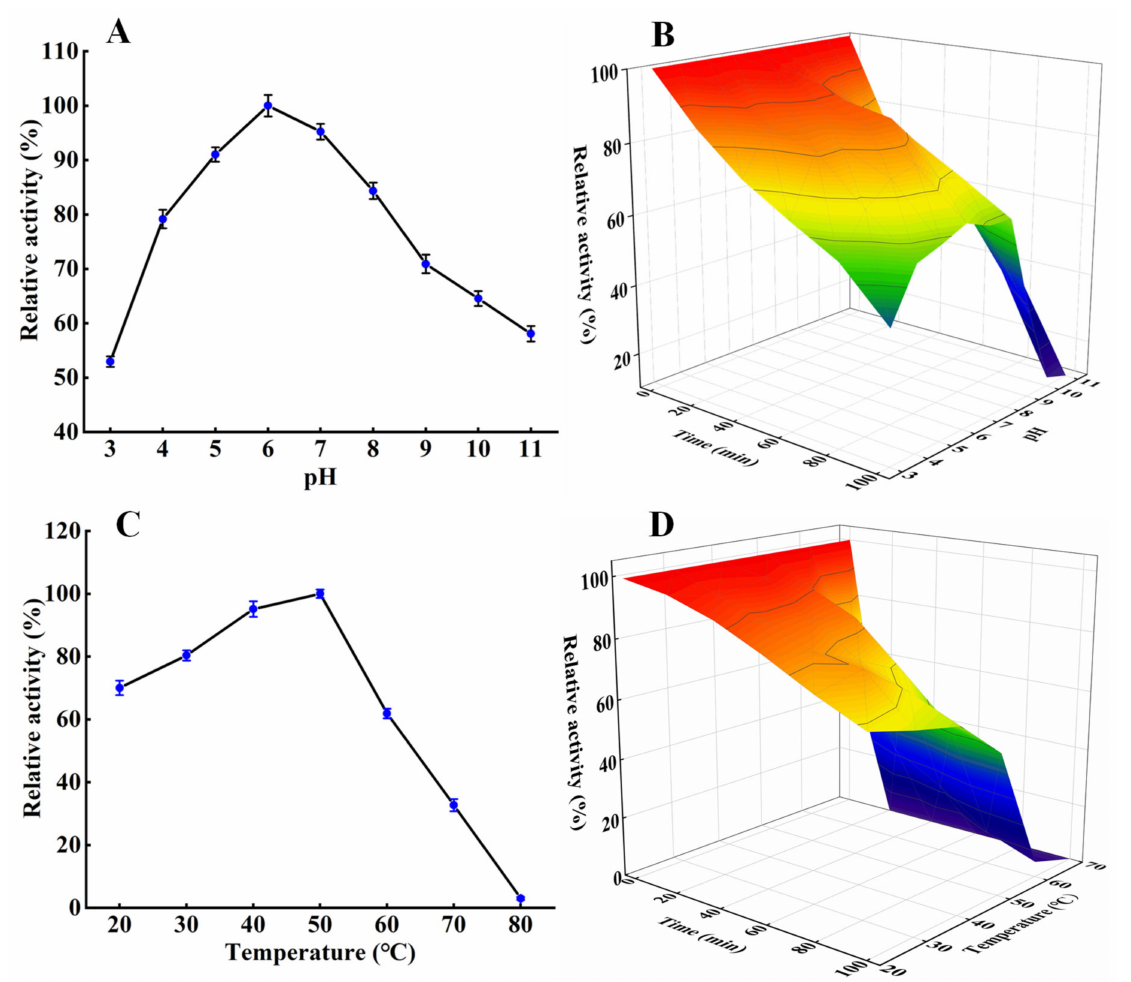
Figure 3. Effect of pH on protease activity ( A ) and stability ( B ); effect of temperature on protease activity ( C ) and stability ( D